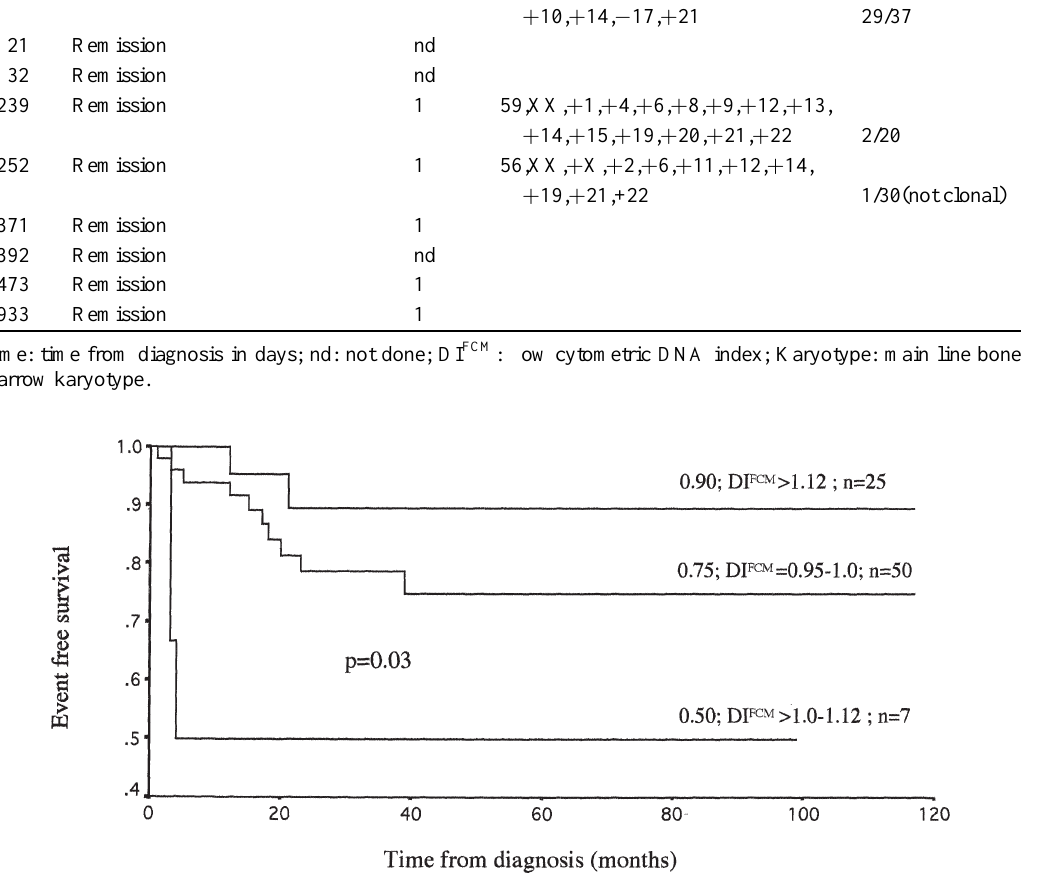
Fig. 4. Probability of event free survival. Cut off points were set at flow cytometric DNA indices (DI FCM ) = 1.0 and 1.12. technique to evaluate ploidy is metaphase karyotyping but also DNA content measurement by flow